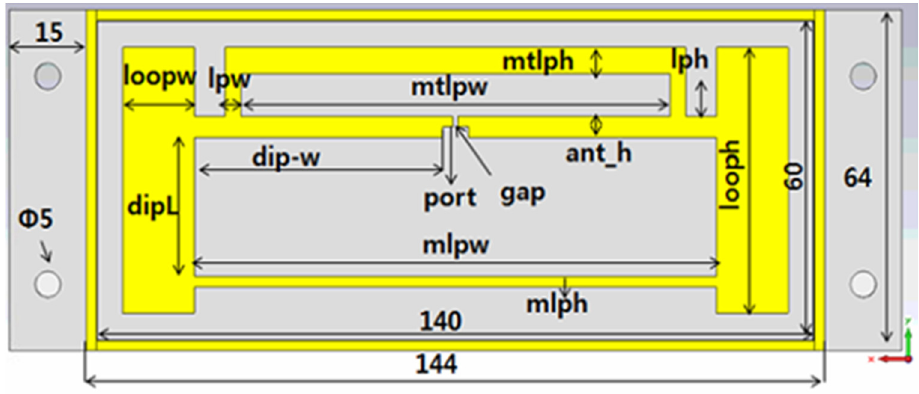
Figure 4. Parameters of the convex cavity structure tag antenna.